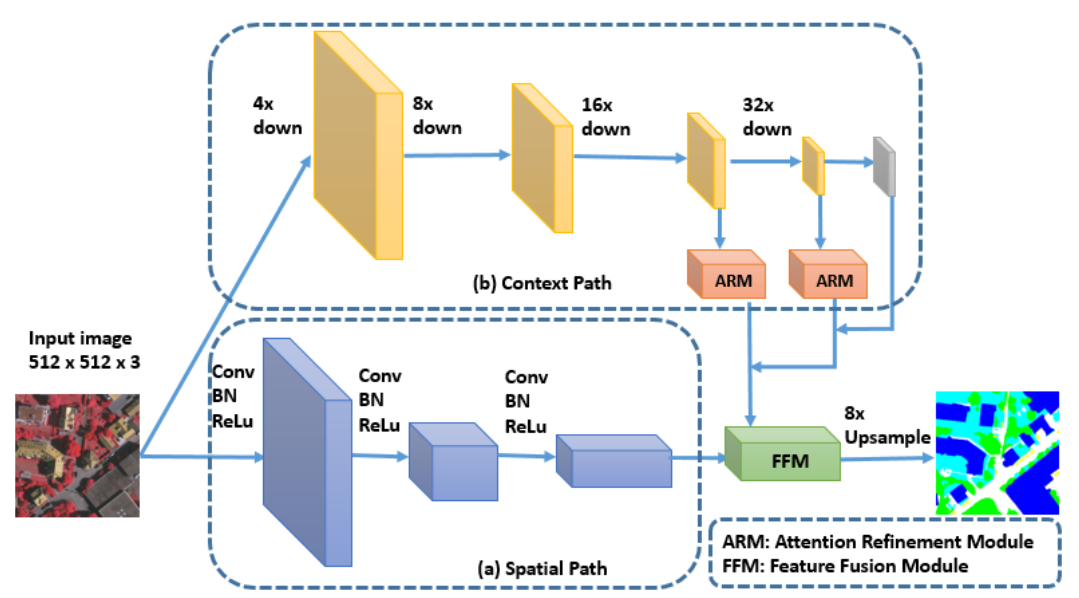
Figure 7. The Architecture of BiSeNet (Bilateral Segmentation Network).